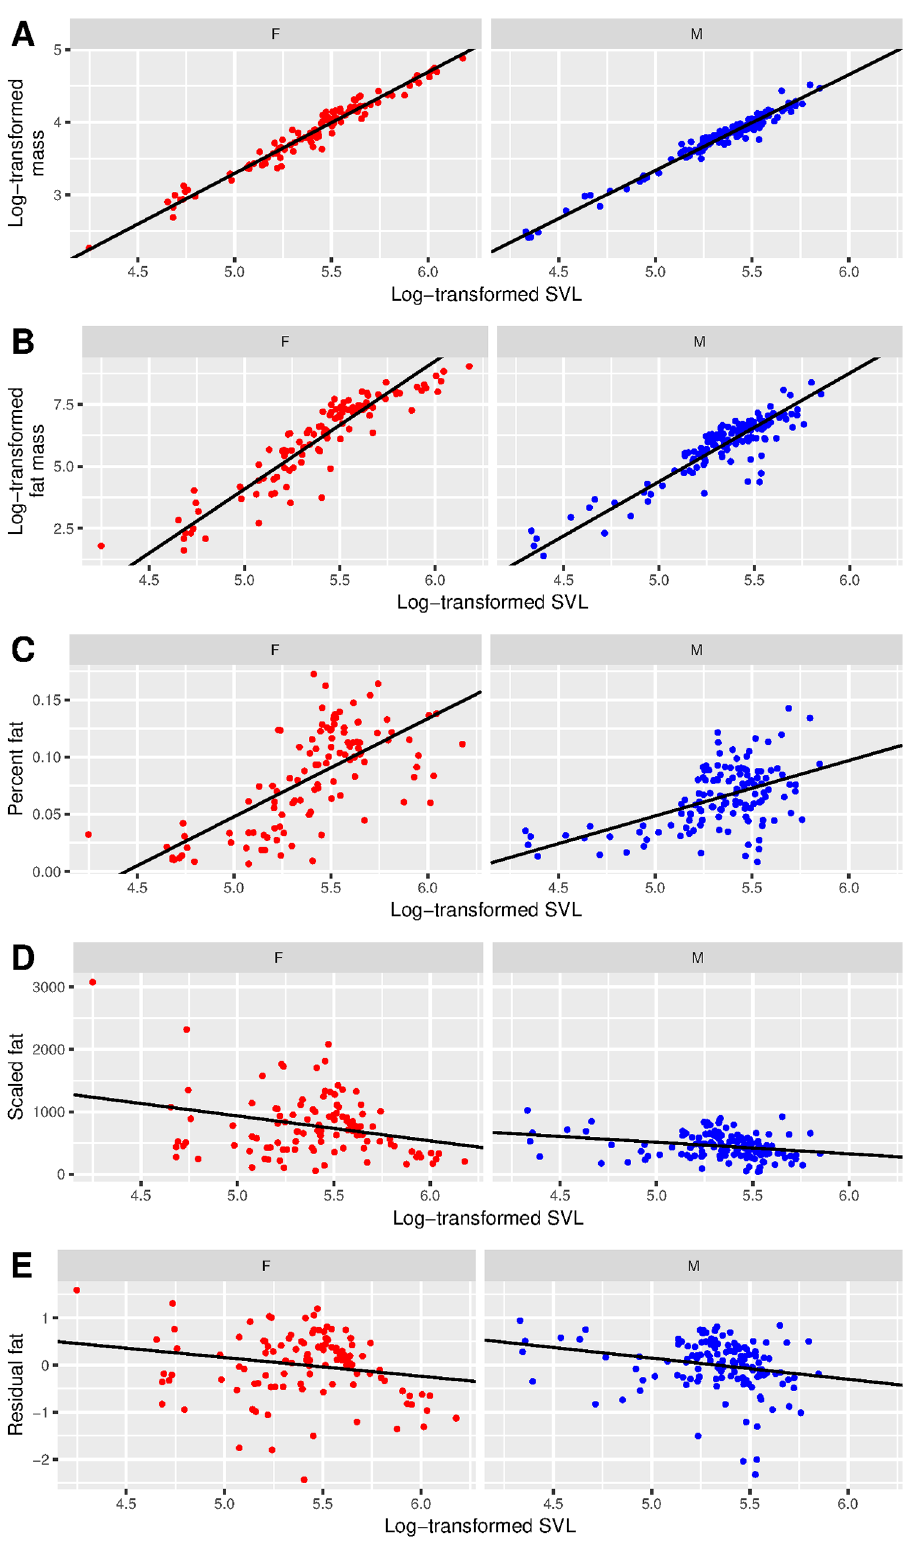
Fig 1. Relationships between snout-vent length (SVL) and mass, fat, and true body condition measuresfor male and female Burmese pythons. The SMA regression of log-transformed body mass on